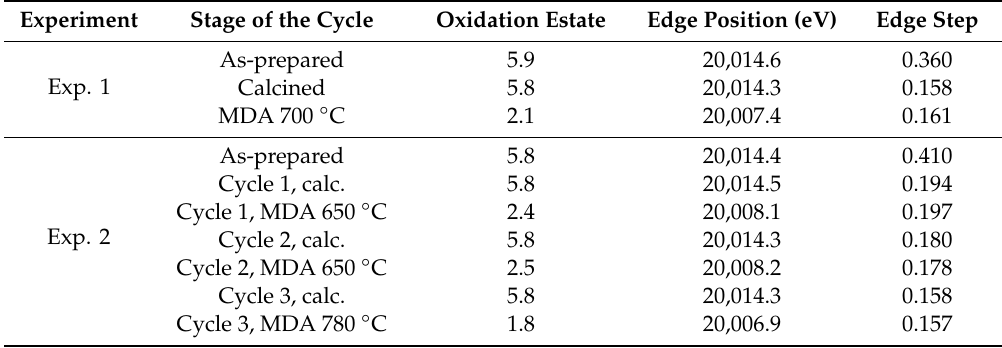
Table 1. Oxidation state, Mo K-edge energies, and edge step values for Mo / H-SSZ-13 after calcination and 70 min of MDA at di ff erent